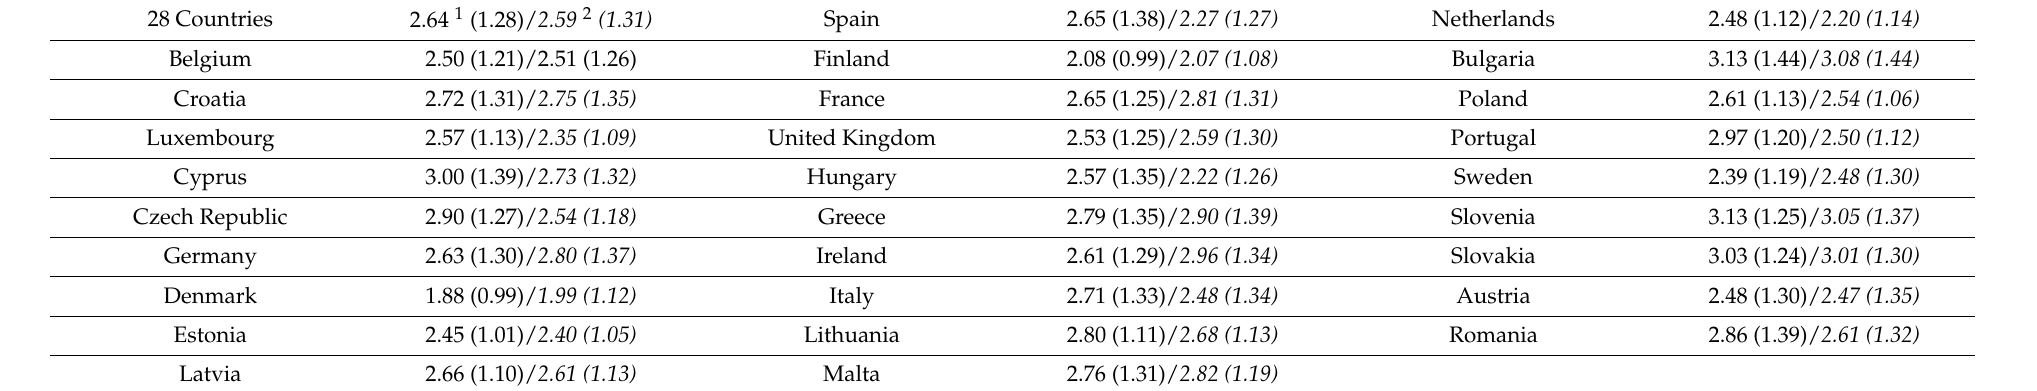
Table 1. Public Opinion about the Effectiveness of Terrorism Policing (Average Score per